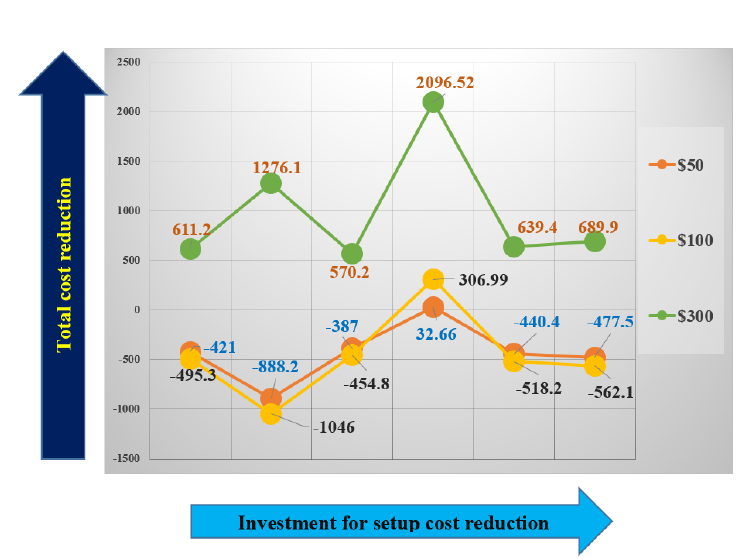
Figure 4. Effect of investment on total